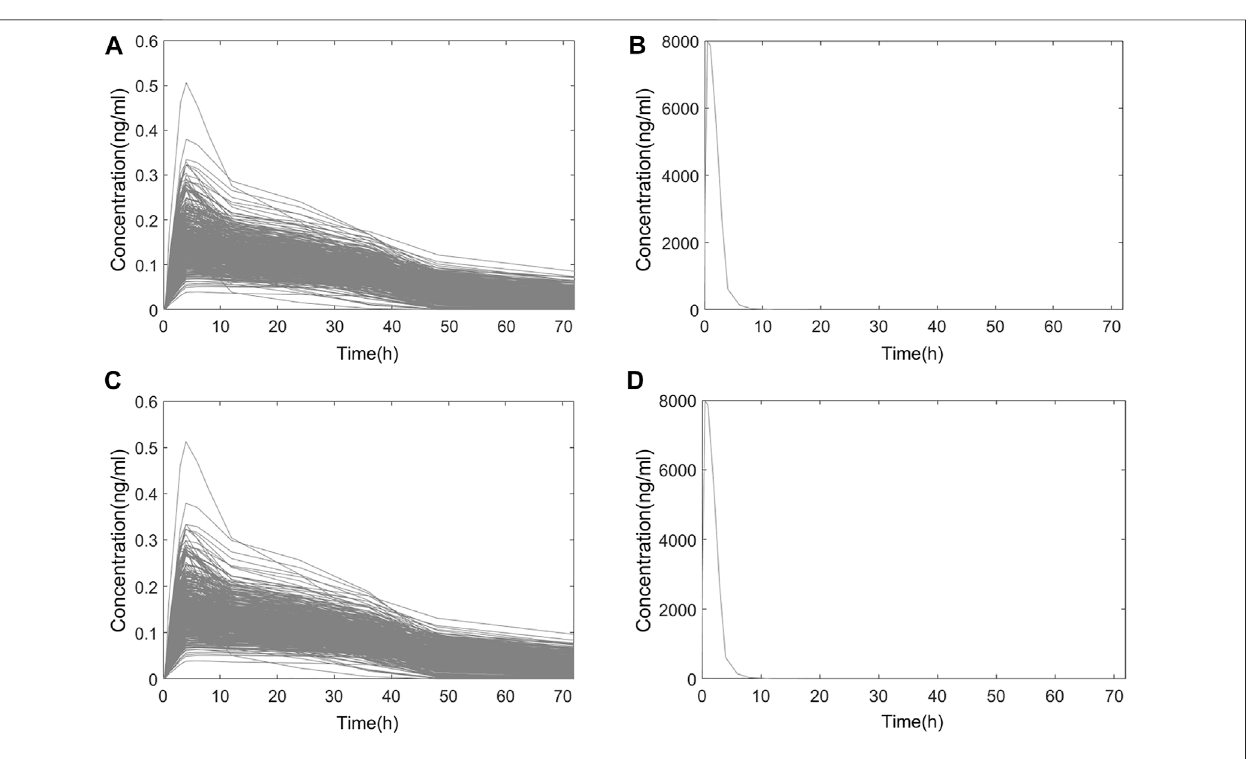
Frontiers in Pharmacology |